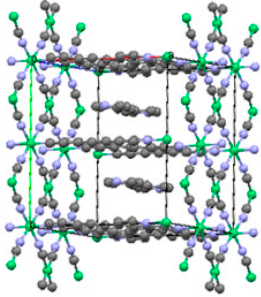
Figure 6. The basic motif of Ni-Bpene (C-grey, N-blue, Ni-green; probability ellipsoids drawn at 50%).